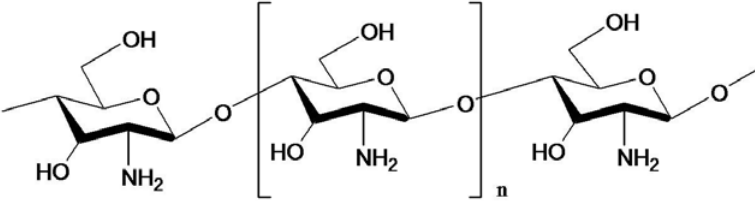
Figure 3. Structure of